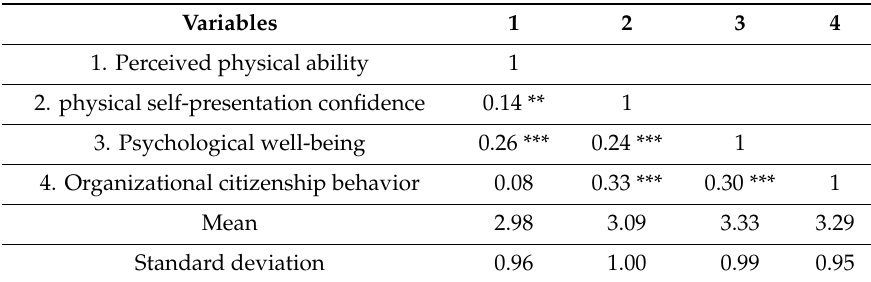
Table 3. Descriptive Statistics and Correlations of Variables.